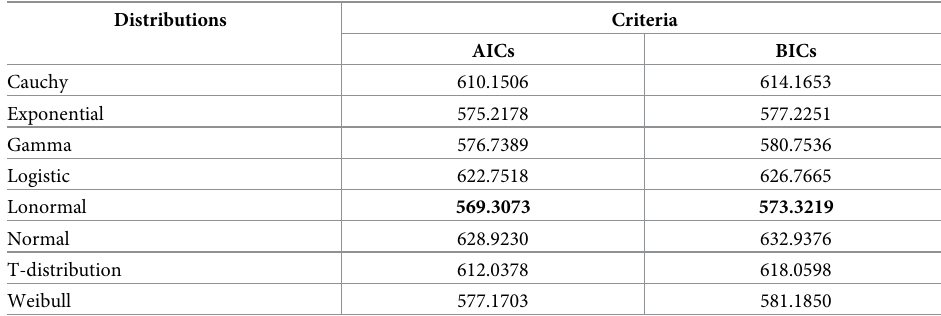
Table 5. Results of AIC and BIC for weekly positive rainfall data.